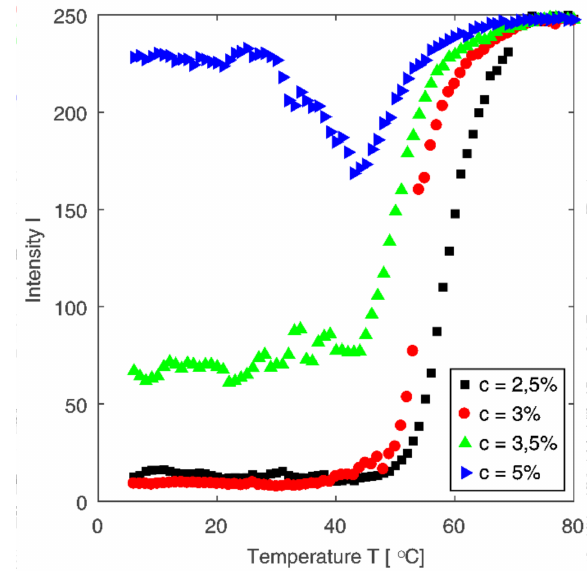
Figure 7. Dependence of intensity (at fixed value of scattering vector q = 1.5 µ m) on temperature for all tested